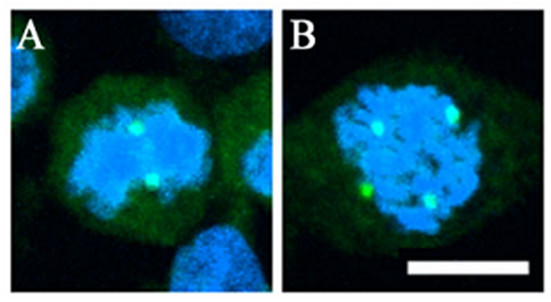
Centrosome defects in the glioma cell line, GBM8401. Centrosomes were visualized with antibodies specific for γ-tubulin (green). DNA was stained with DAPI (blue). Bar: 10 μm, magnification 2000 ×. A, Bipolar spindles. B, Multipolar spindles.